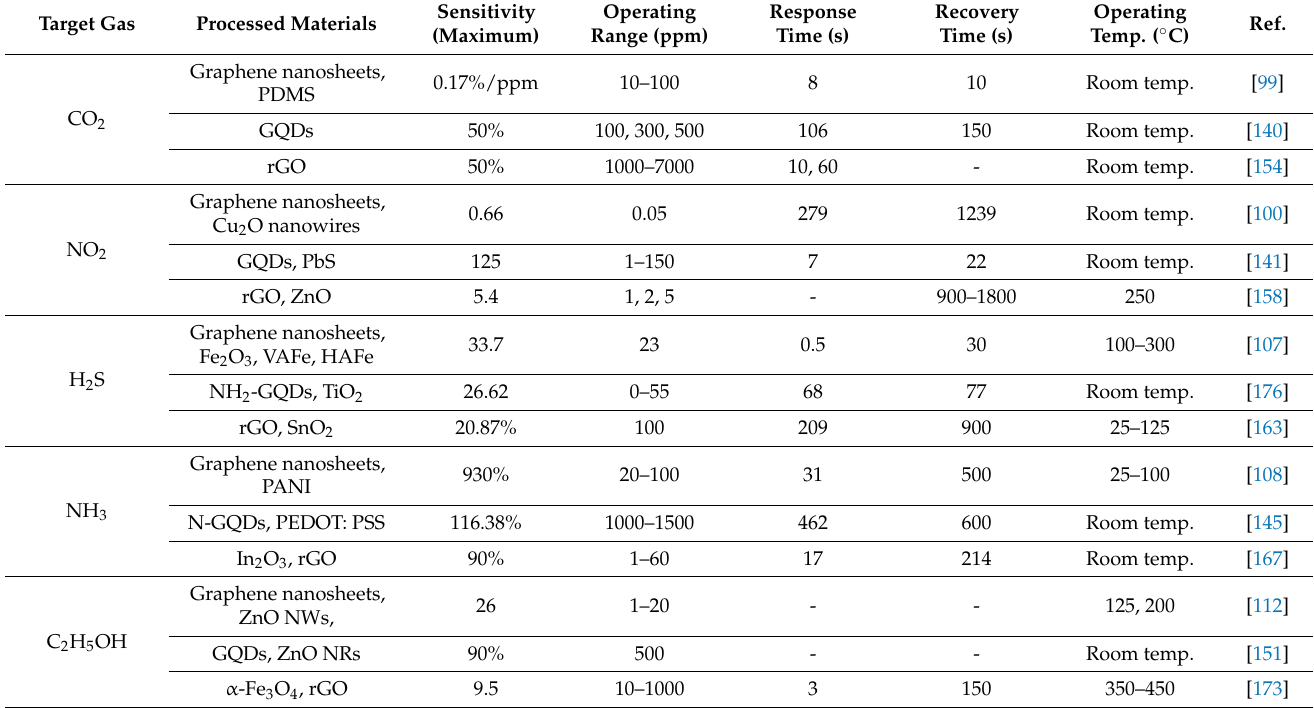
Table 1. Comparison of the performances of different graphene-based gas